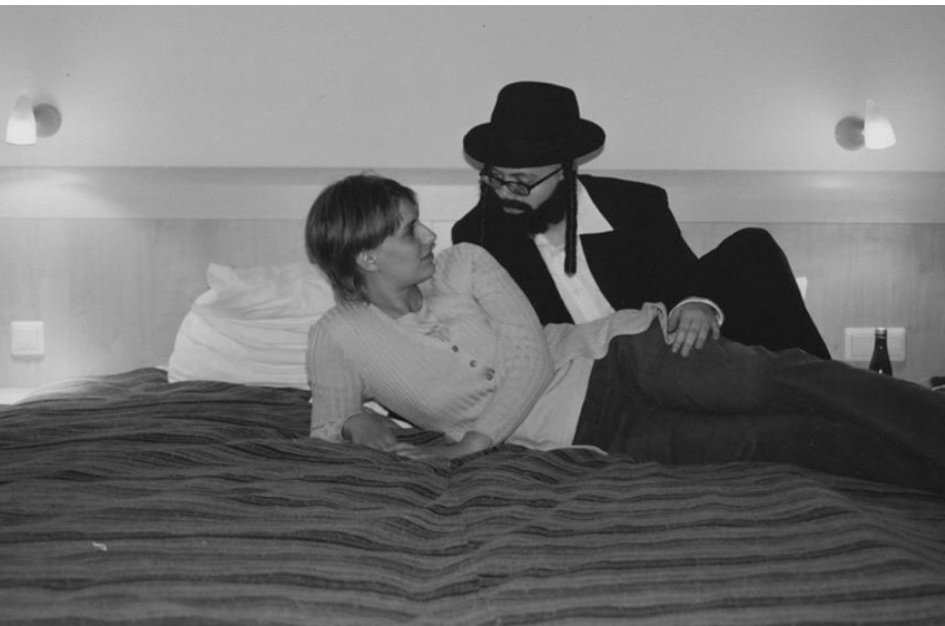
Figure 10. Oreet Ashery, Say Cheese , 2002, performance documentation, City of Women Festival, Kapelica Gallery, Ljubljana, Slovenia.